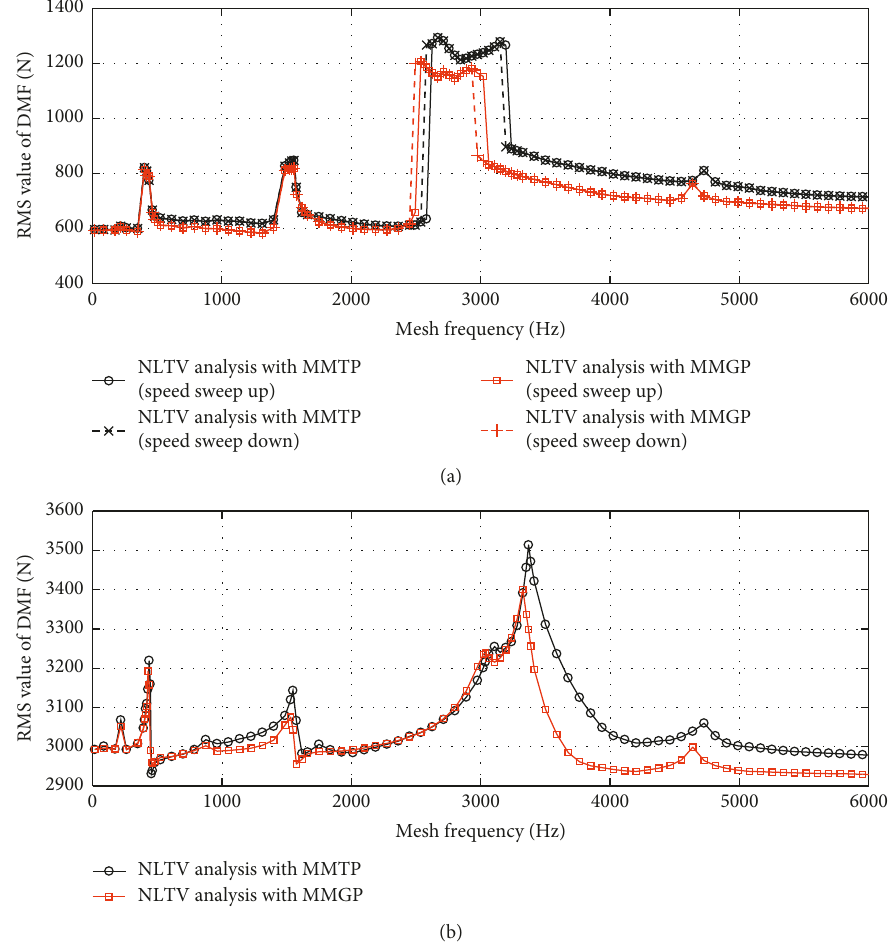
Figure 16: RMS values of the DMF acting on the individual tooth pair evaluated at (a) 50 Nm and (b) 300Nm torque loads.